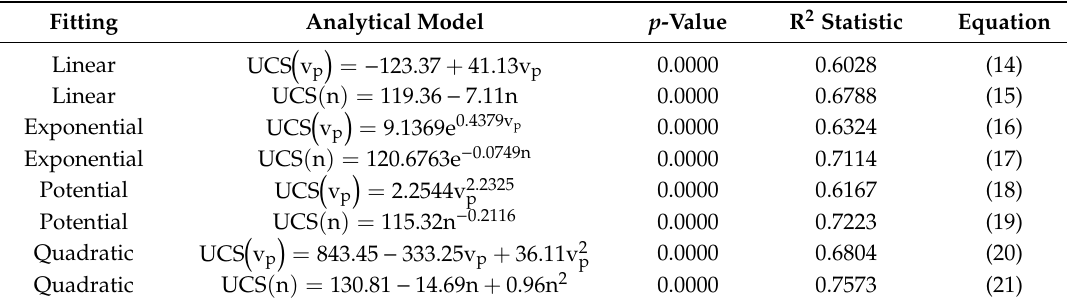
Table 4. Summary of univariant analytical models.